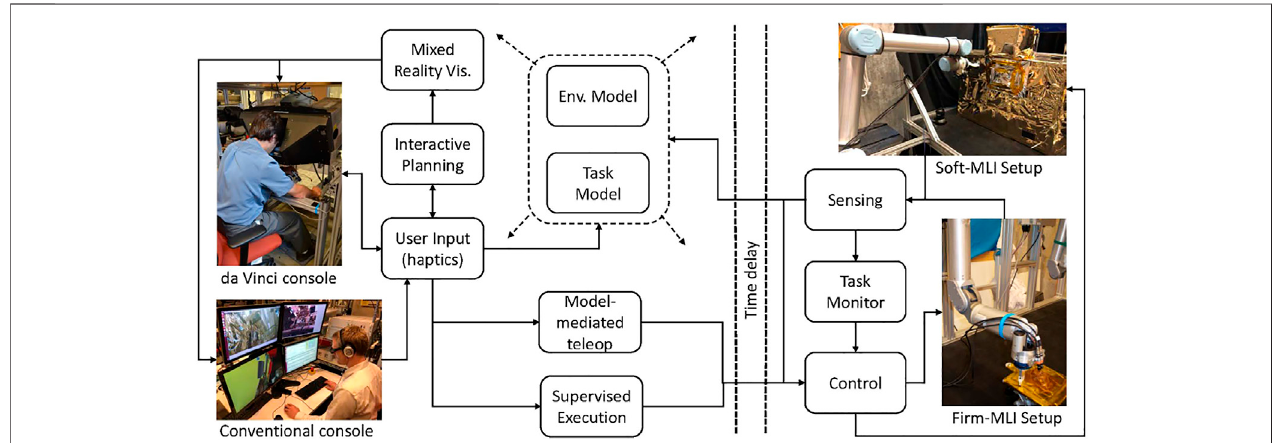
FIGURE 1 | Model-based architecture, showing two teleoperation consoles (conventional and da Vinci) and two test platforms (Firm-MLI and Soft-MLI setups).